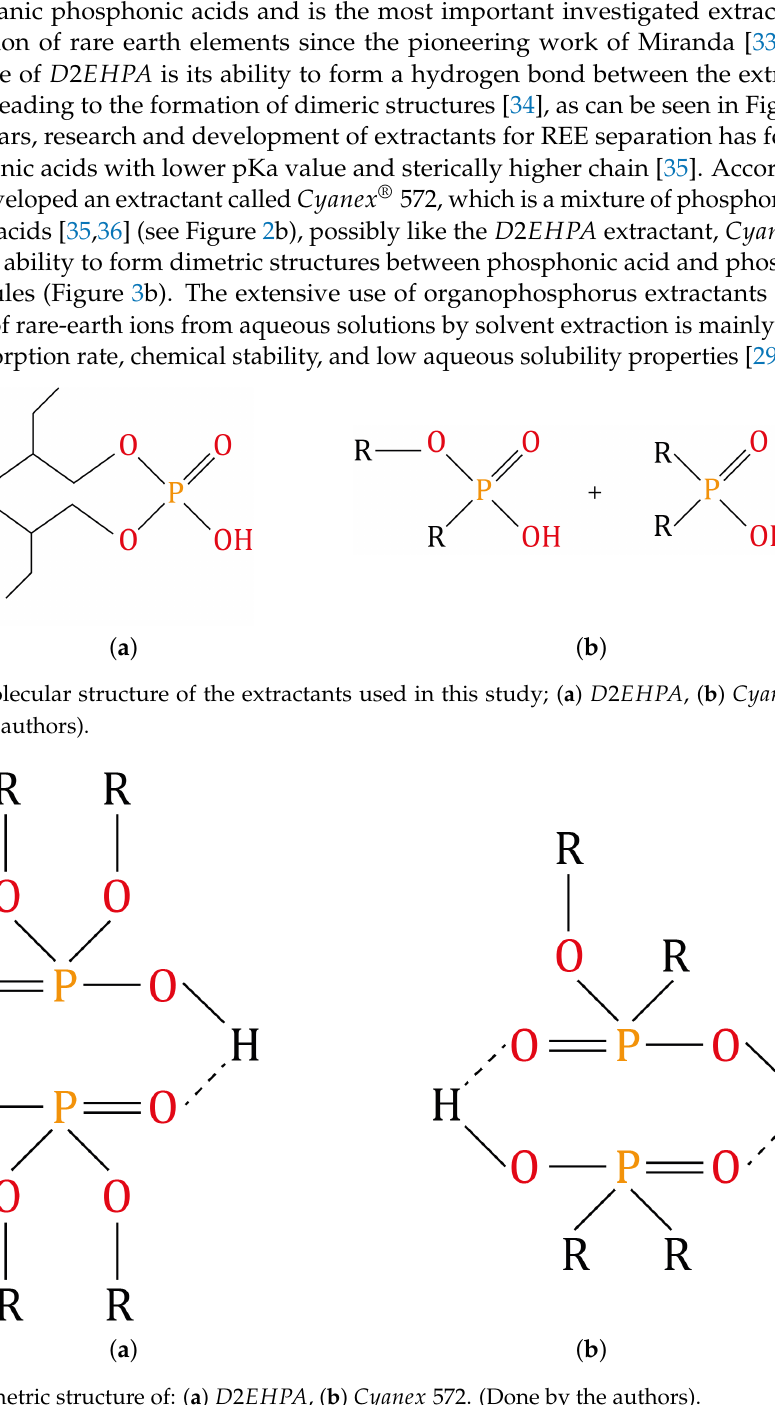
Figure 3. Dimetric structure of: ( a ) D 2 EHPA , ( b ) Cyanex 572. (Done by the